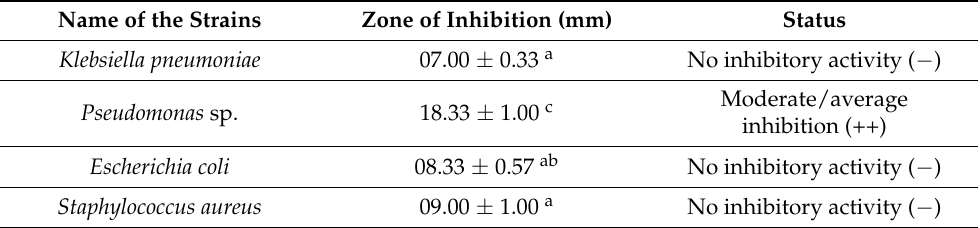
Table 1. Antagonistic activity of Bacillus subtilis against the selected bacteria. Different letters indicate significant differences between mean ± SD of replications ( n = 3) at a p < 0.05 significance level. Name of the Strains Zone of Inhibition (mm) Status Klebsiella pneumoniae 07.00 ± 0.33 a No inhibitory activity ( − ) Moderate/average Pseudomonas sp. 18.33 ± 1.00 c inhibition (++) Escherichia coli 08.33 ± 0.57 ab No inhibitory activity ( − ) Staphylococcus aureus 09.00 ± 1.00 a No inhibitory activity ( − )